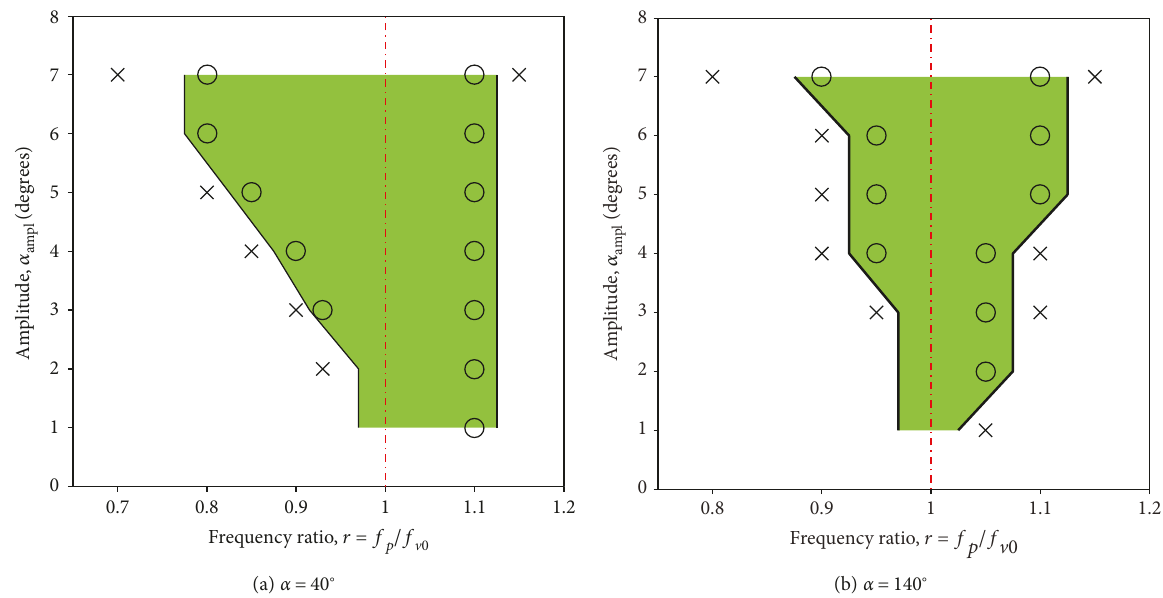
Figure 6: Lock-in region for pitching amplitude analysis at two incidences: ○ , lock-in; × , lock-out and lock-in region (in-green). Velocity.Curl Z 5.0